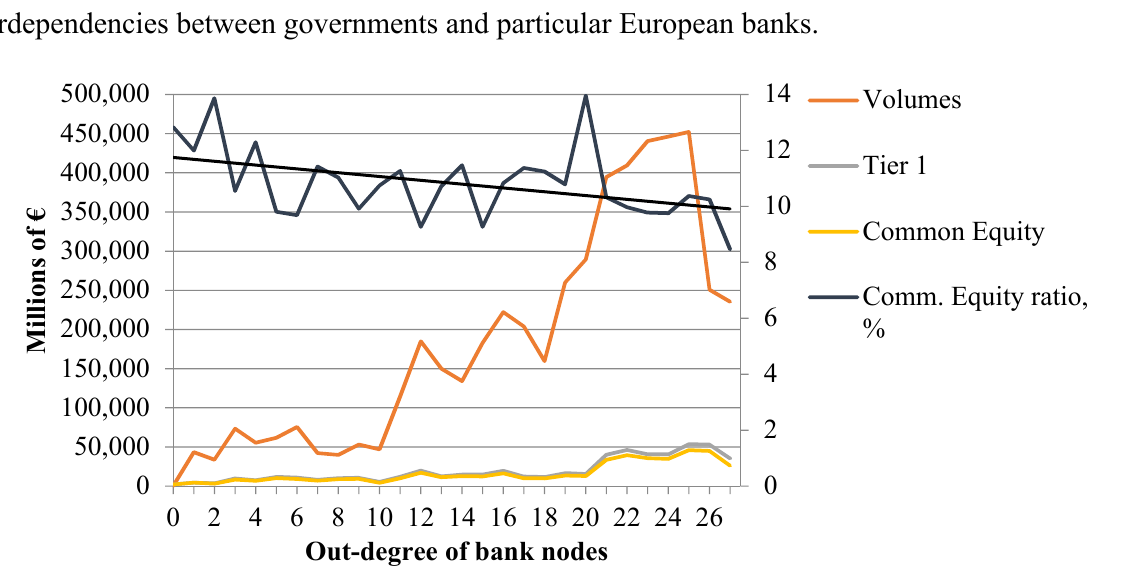
Figure 4. Average Balance Sheet Characteristics and Sovereign Debt Portfolios of Banks per Connectivity Level. Volumes of (gross direct long) sovereign debt exposures, Tier 1 and common equity levels are stated in millions of euros. The common equity ratio was calculated on